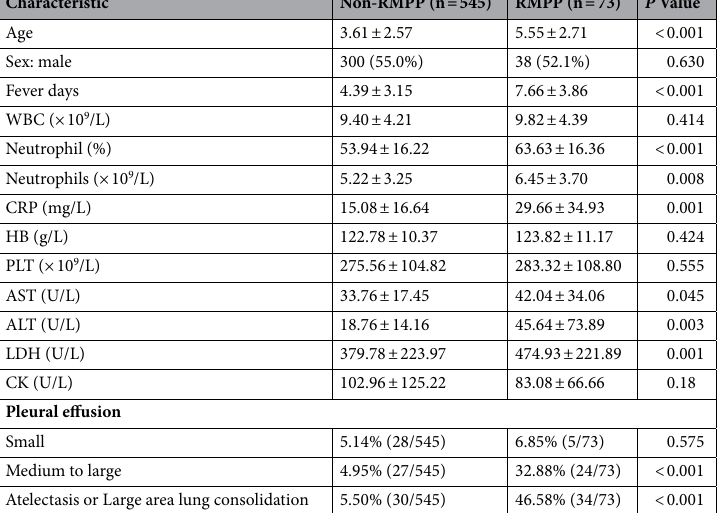
Table 2. Admission characteristics of children with Mycoplasma pneumoniae pneumonia in the retrospective cohort according to their subsequent clinical outcome. Values are presented as mean ± SD. ALT alanine aminotransferase, AST aspartate aminotransferase, CK creatine kinase, CRP C-reactive protein, HB hemoglobin, LDH lactate dehydrogenase, PLT platelet, RMPP refractory M. pneumoniae pneumonia, WBC white blood